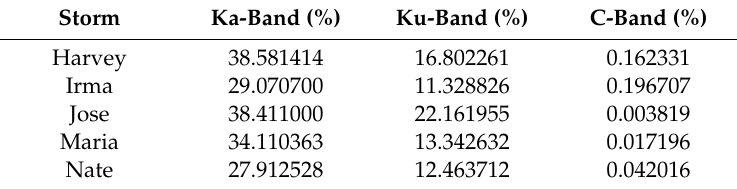
Table 2. Percentage of Rain Contamination (Serious and Side Lobe) using 2.75 km Footprint.